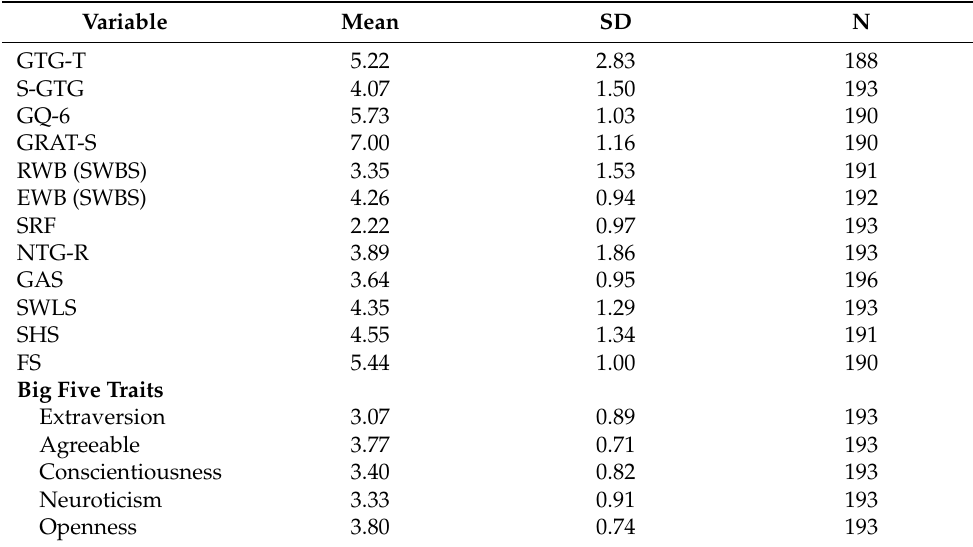
Table 2. Means and Standard Deviations at Time